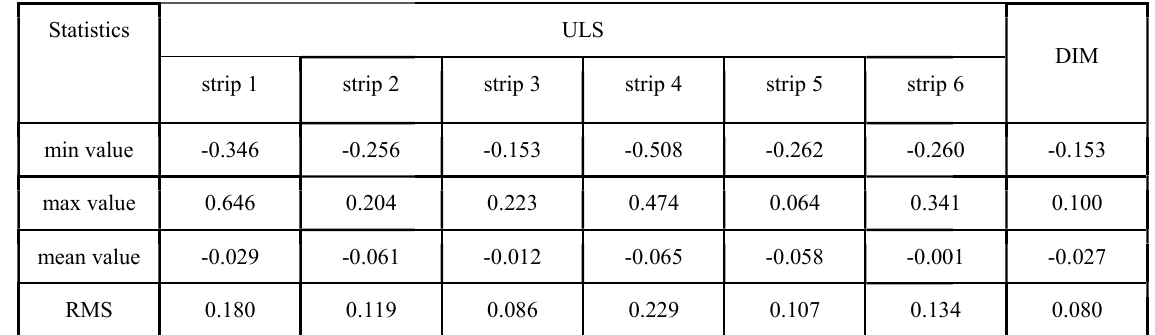
Table 5. Density of obtained ULS, TLS and DIM point clouds